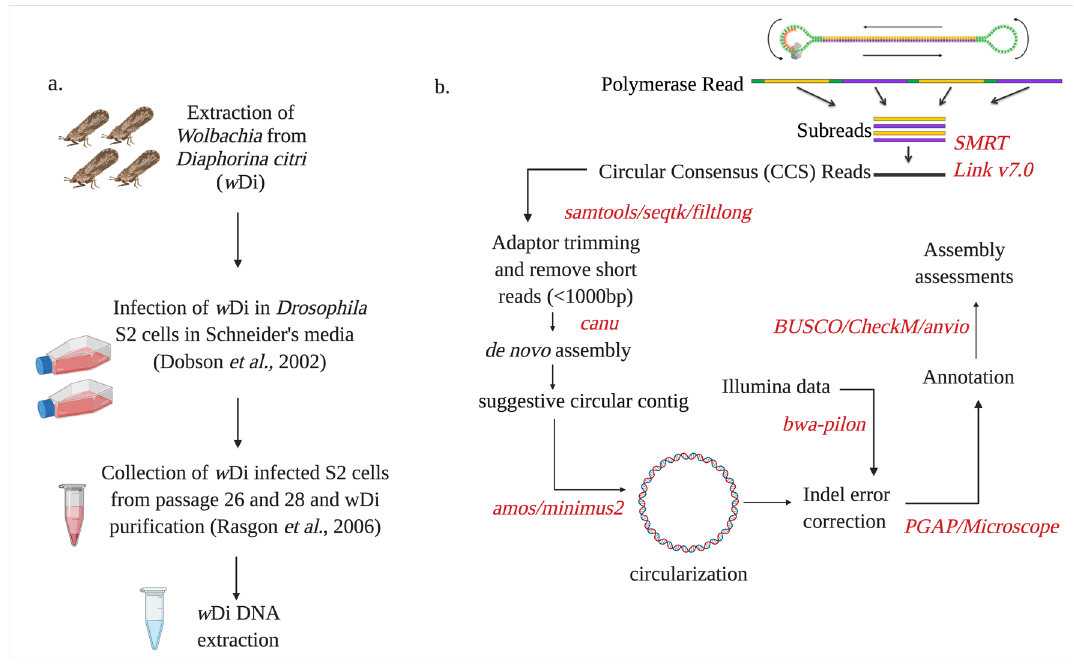
Figure 1. An overview of w Di extraction experiments and genome assembly pipeline. ( a ) A flow chart representing w Di extraction, culture, purification and w Di DNA extraction. ( b ) A flow chart showing w Di genome assembly